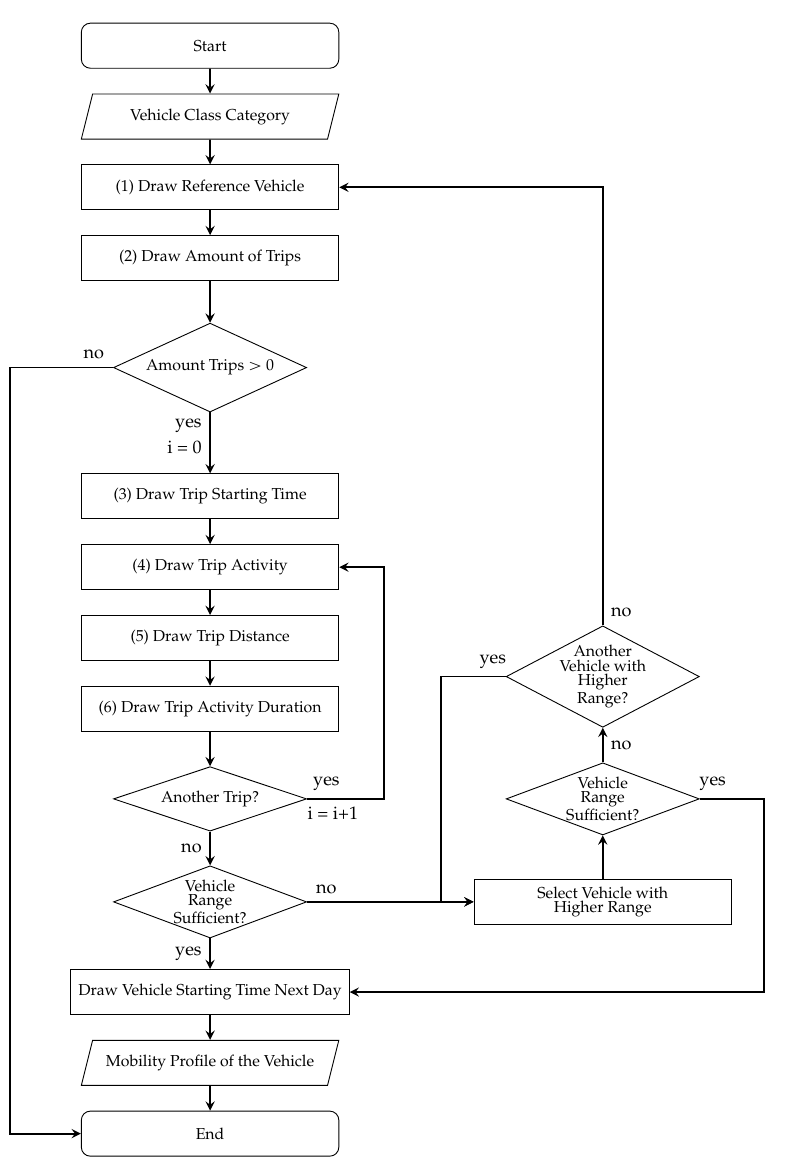
Figure 5. General process for creating the mobility profile for one vehicle.